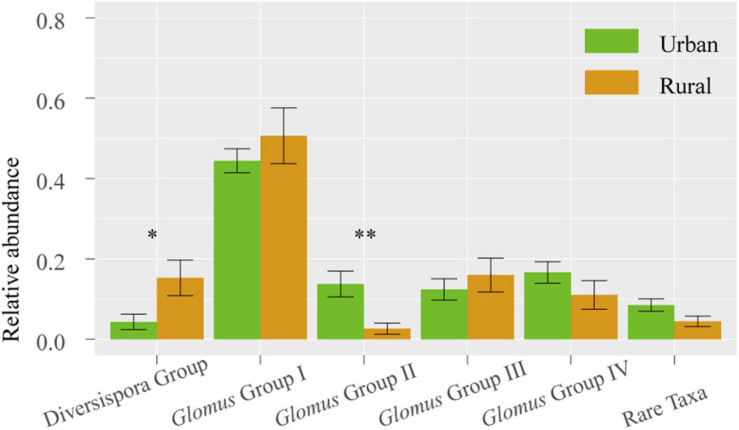
Relative abundances of AM fungal groups in urban and rural samples. The vertical bars represent the standard error of the mean (n = 8). *LSD significant at the 0.05 level; **LSD significant at the 0.01 level.